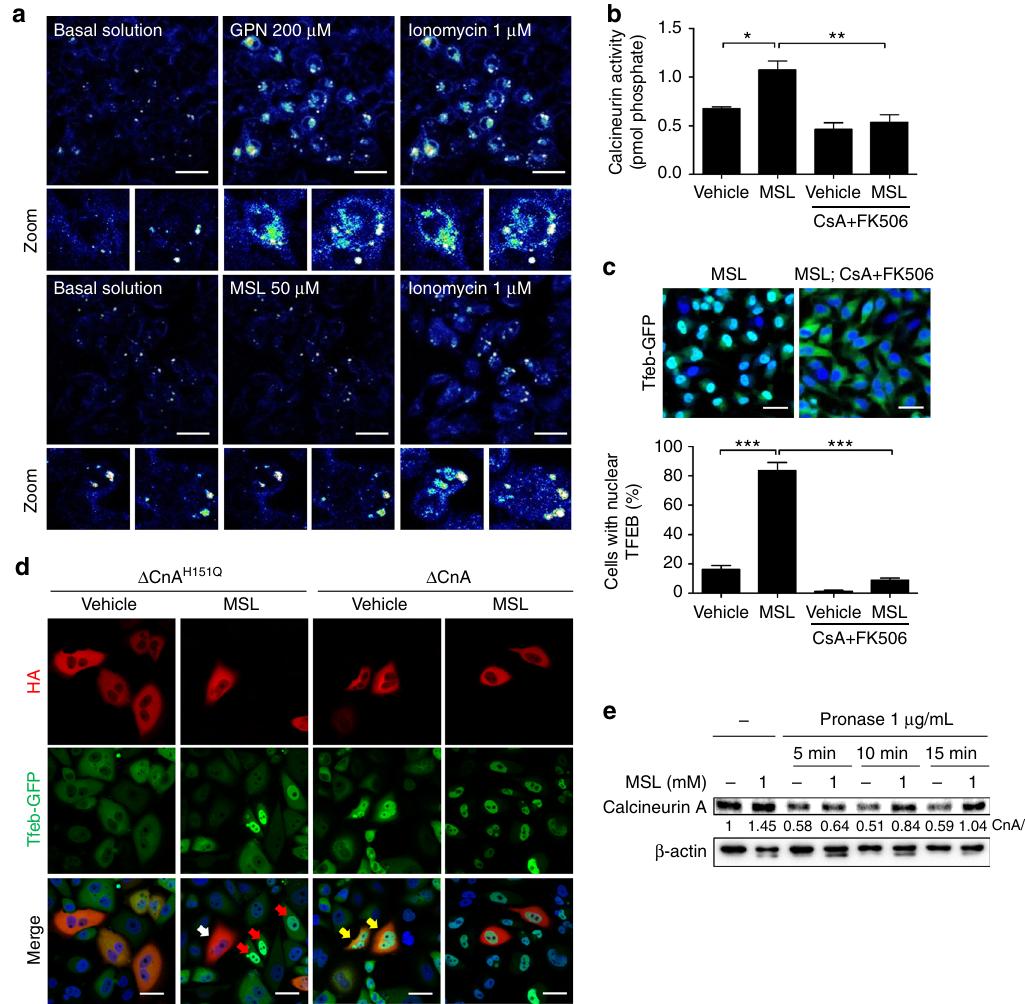
Fig. 2 MSL-induced calcineurin activation increases autophagic fl ux. a HeLa cells transfected with GCaMP3-ML1 encoding a lysosome-speci fi c Ca 2 + probe were treated with GPN, ionomycin or MSL. Lysosomal Ca 2 + release was visualized by confocal microscopy. b Cells were treated with 50 μ M MSL with or without pretreatment with CsA + FK506 combination ( F = 13.4, df treatment = 3, df residual = 6). c Tfeb-GFP -transfectants were treated with MSL with or without pretreatment with CsA + FK506 combination, and then subjected to confocal microscopy (upper). The number of cells with nuclear TFEB was counted ( F = 133.5, df treatment = 3, df residual = 11) (lower). d Tfeb-GFP -transfectants were transfected with HA - Δ CnA -H151Q or - Δ CnA construct, and analyzed by confocal microscopy after treatment with MSL for 4 h and immunostaining with anti-HA antibody (white arrow, HA - Δ CnA -H151Q-transfected cells showing no TFEB translocation by MSL; red arrows, HA - Δ CnA -H151Q-untransfected cells showing TFEB translocation by MSL; yellow arrows, HA - Δ CnA -transfected cells showing TFEB translocation without MSL). e Cell lysate was treated with pronase with or without MSL pretreatment, and subjected to Western blot analysis using anti-calcineurin A antibody. Numbers below immunoblot bands indicate fold changes normalized to β -actin bands (scale bar, 20 μ m). All data in this fi gure are the means ± s.e.m. from ≥ 3 independent experiments performed in triplicate. * P < 0.05, ** P < 0.01 and *** P <